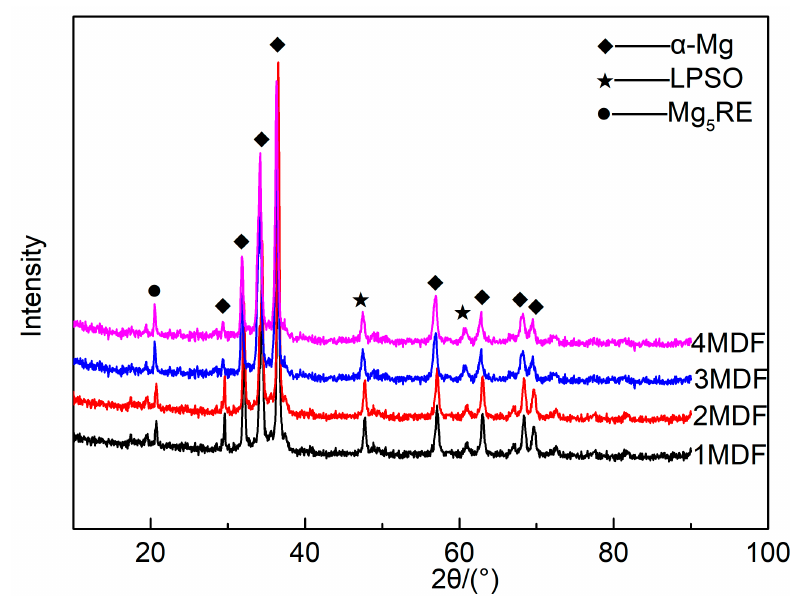
Figure 7. X-ray di ff raction patterns of MDFed alloy after di ff erent passes. Figure 7. X-ray diffraction patterns of MDFed alloy after different passes. Figure 7. X-ray diffraction patterns of MDFed alloy after different passes.